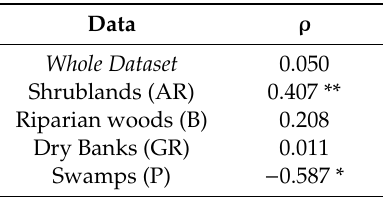
Table 2. Spearman correlations ( ρ ) between plant and lichen species richness for the whole set of data and for each habitat separately. (** p < 0.01; * p <